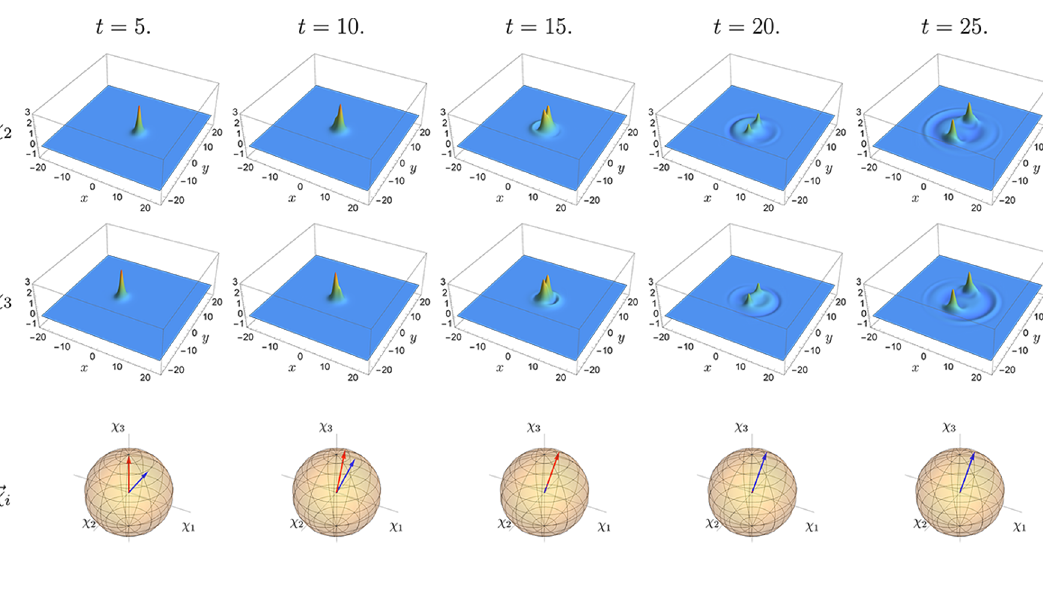
Figure 30 . Snapshots of χ 2 and χ 3 for the head-on collision of type II non-Abelian orthogonal vortices with initial velocity u = 0 . 6 . The vortices scatter at right angles, their orientations having become parallel to each other at the time of collision, and continuing to be so in the asymptotic outgoing state. Internal orientations in S 3 are represented in the last